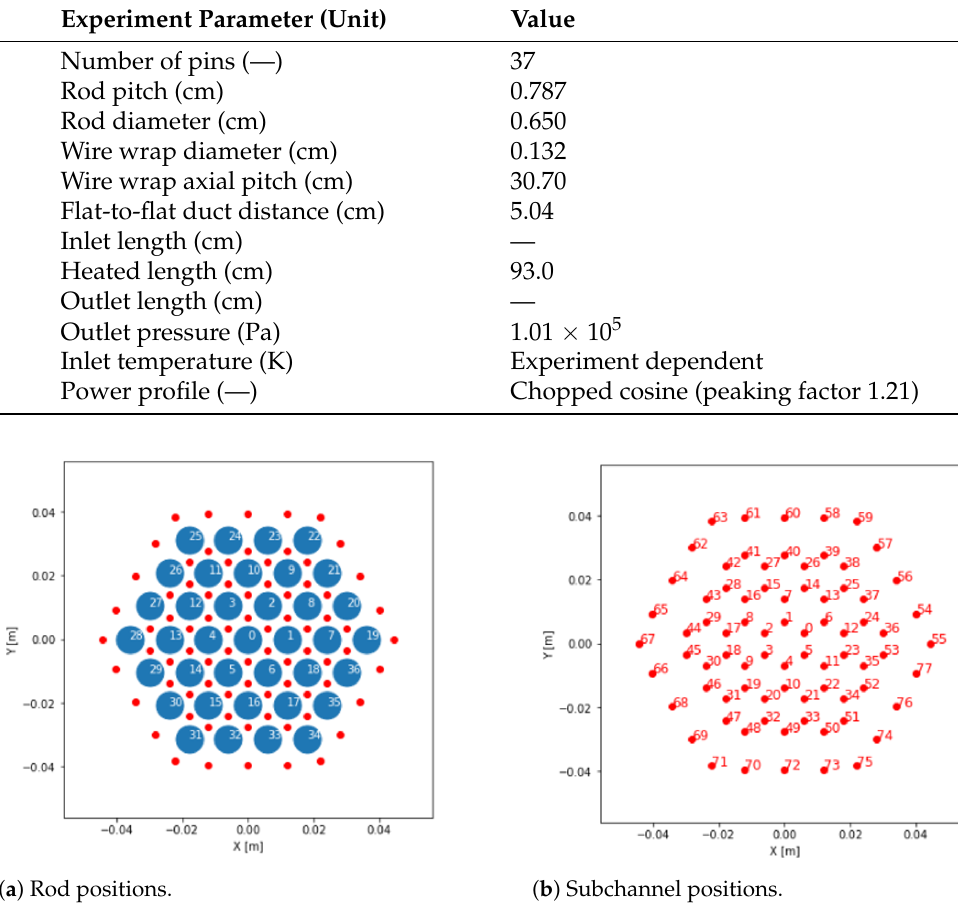
Figure 8. Rod and subchannel positions and numbering adopted for the Toshiba 37-pin benchmark. ( a ) Position and numbering of the heated rods with the subchannel center indicated with red dots. ( b ) Center position and numbering of the